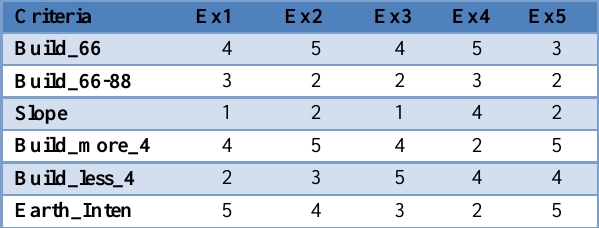
Table 1. Different layer weights based on different experts